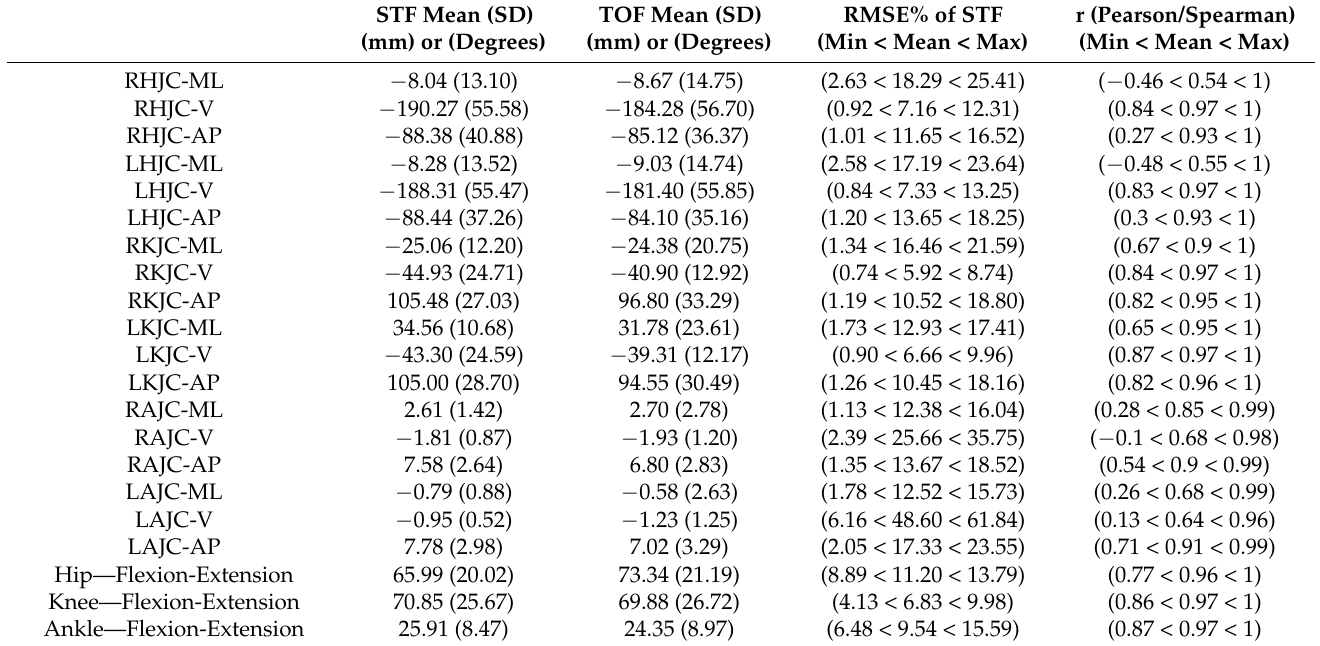
Table 2. Results of the comparison between joint center trajectories and joint sagittal angles based on the markers reconstructed with stereophotogrammetry (STF) and those reconstructed through Track On Field (TOF): RMSE% and Pearson/Spearman’s correlation coefficient. R = right; L = left; H = hip; K = knee; A = ankle; JC = joint center; ML = medial lateral direction; V = vertical direction; AP = anterior posterior